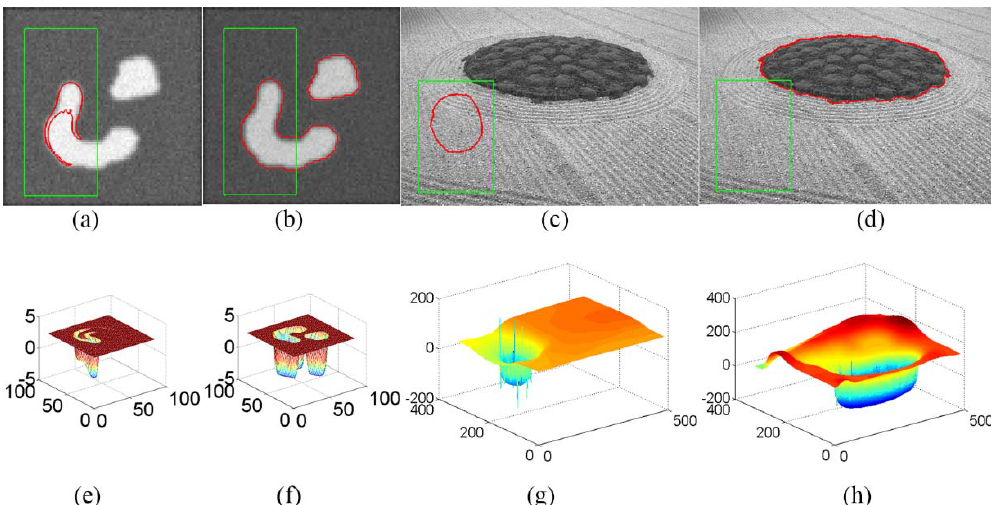
Figure 4. Comparison between the segmentation results of the two-step splitting method (TSSM) in [30] and the proposed method. ( a , c ) are the segmentation results by TSSM, and ( e , g ) are the corresponding final level set functions. ( b , d ) show the segmentation results by the proposed method, ( f , h ) are the corresponding final level set functions. The horizontal axis of ( e – h ) indicate the width and height of image ( a , c ), and their size are 100 × 100 and 500 × 400, respectively. The value of the vertical axis of ( e – h ) can be artificially set. The green solid lines represent the initial contours.